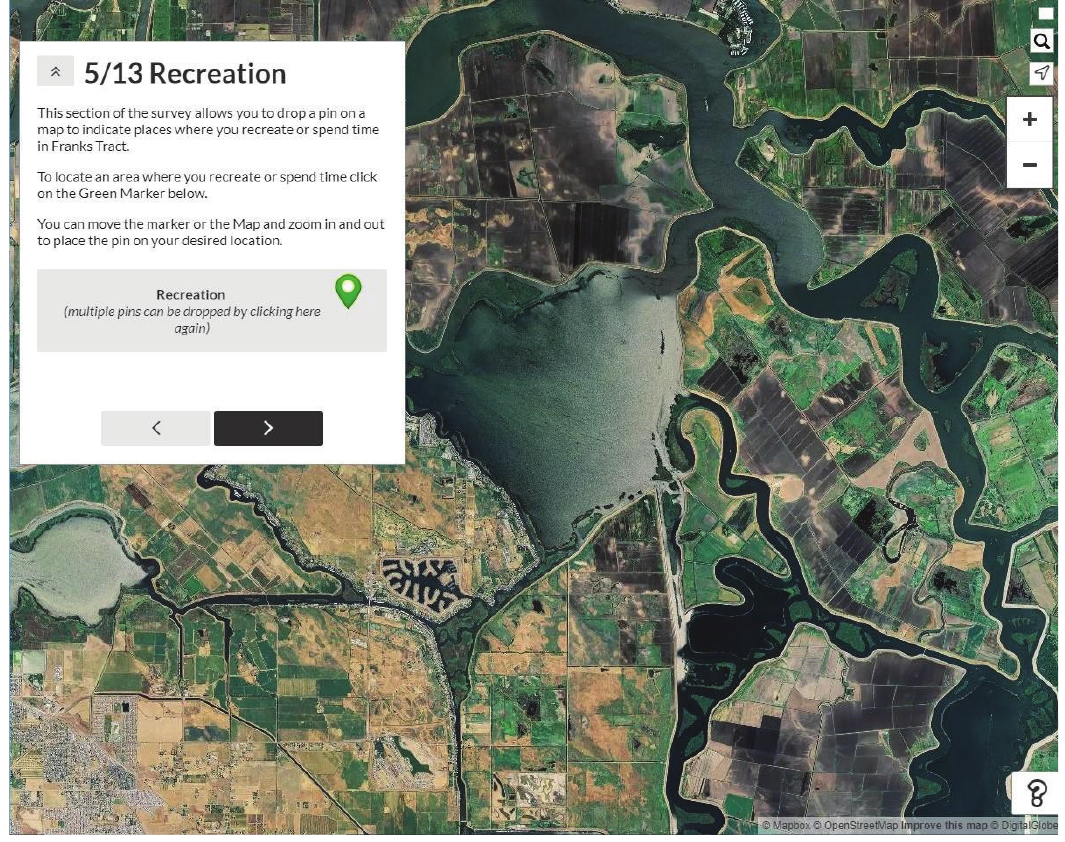
Figure 3. Image of the user survey